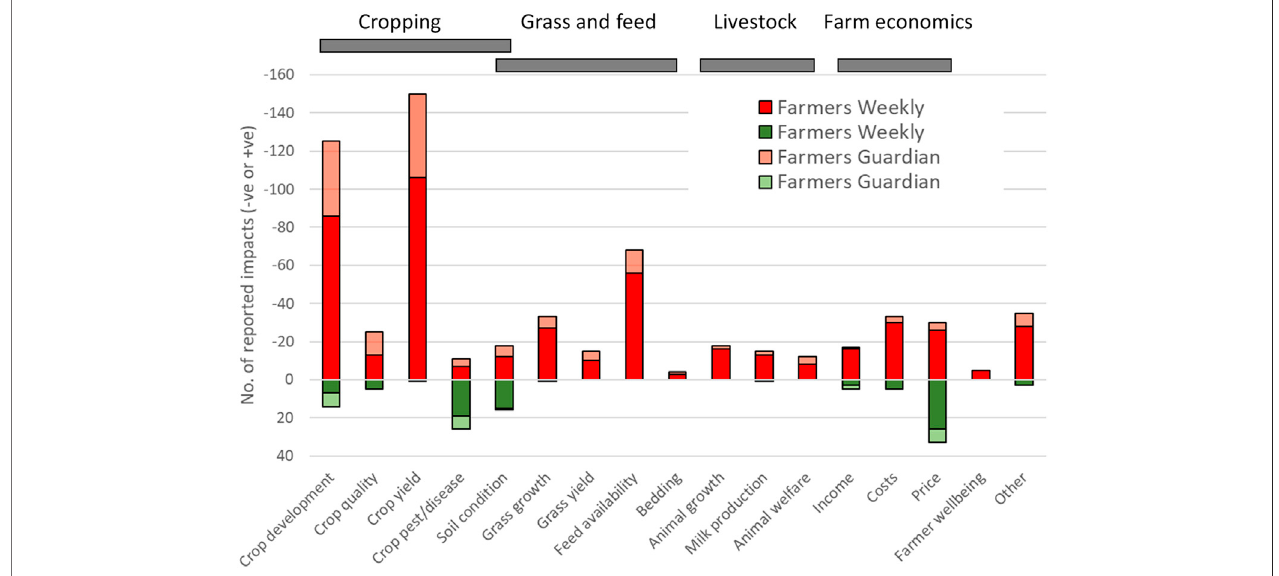
FIGURE 3 | Negative and positive drought impacts reported in Farmers Weekly and Farmers Guardian trade magazines in 2018.